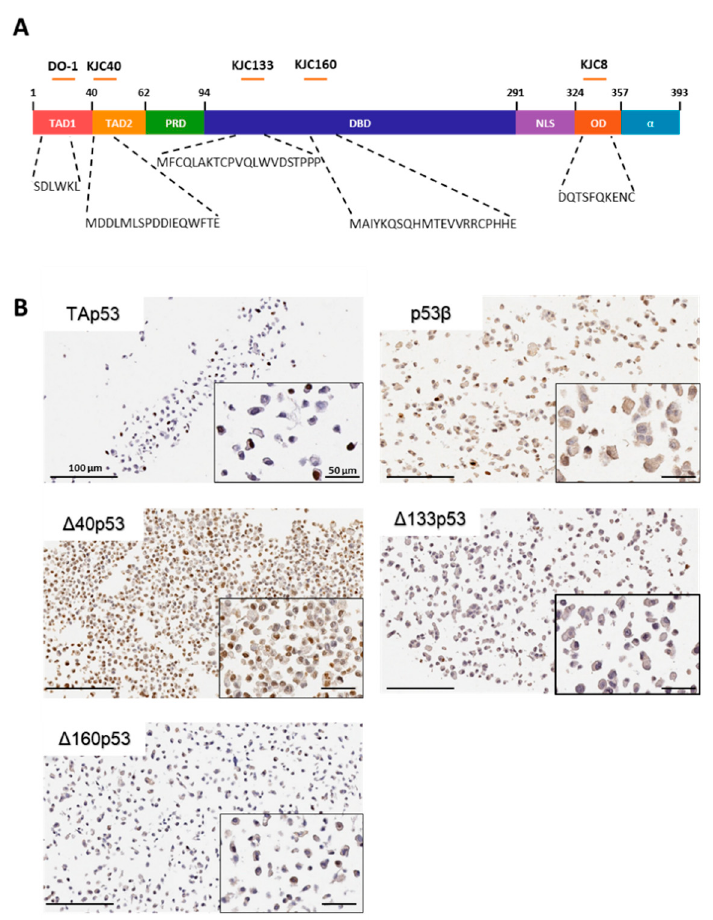
Figure 1. Characterisation of p53 isoform protein expression using immunohistochemistry. ( A ) Antibody epitopes within p53 ′ s functional domains. TAD1: transactivation domain 1, TAD2: transactivation domain 2, PRD: proline-rich domain, DBD: DNA-binding domain, NLS: nuclear localisation signals, OD: oligomerisation domain and α : C-terminal domain. The mouse monoclonal antibody DO-1 detects the sequence SDLWKL of TAD1; the rabbit polyclonal antibody KJC40 recognises MD- DLMLSPDDIEQWFTE with specific post-translational modifications; the rabbit polyclonal antibody KCJ8 recognises the region DQTSFQKENC of the alternatively spliced p53 β sequence; the epitope for the rabbit polyclonal antibody KJC133 is between position 133 and 153, and the epitope for the rabbit polyclonal antibody KJC160 is between 160 and 180 using p53 α amino-acid sequence. ( B )